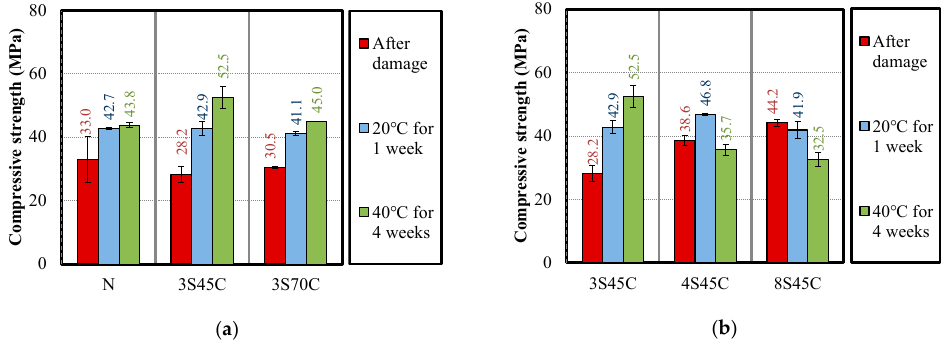
Figure 11. Compressive strength results after damage and after water curing for different ( a ) BFS replacement ratios and ( b ) BFS Blaine fineness values.